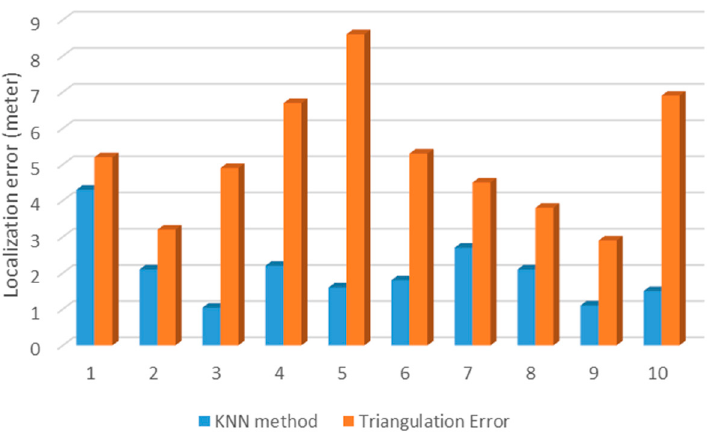
Figure 16. Localization error for KNN and triangulation systems in 10 different testing points.